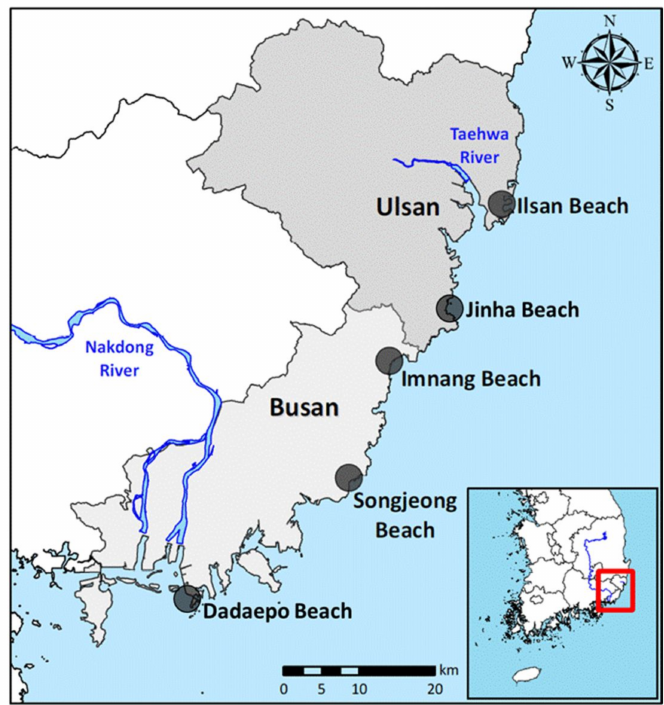
Figure 1. Target beaches in Ulsan and Busan and sampling locations at each beach, South